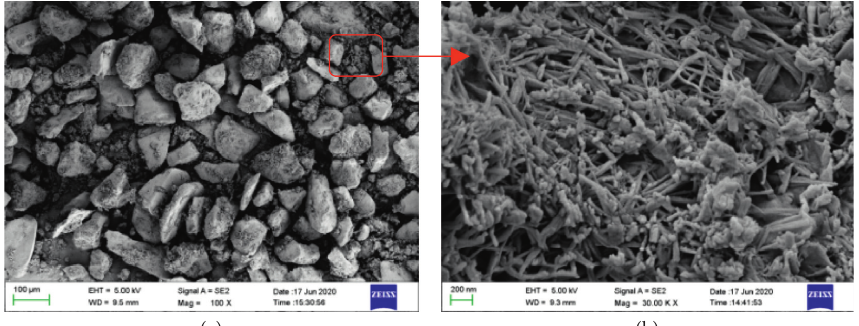
Figure 6: Microstructure of saline soils stabilised with Ca(OH)